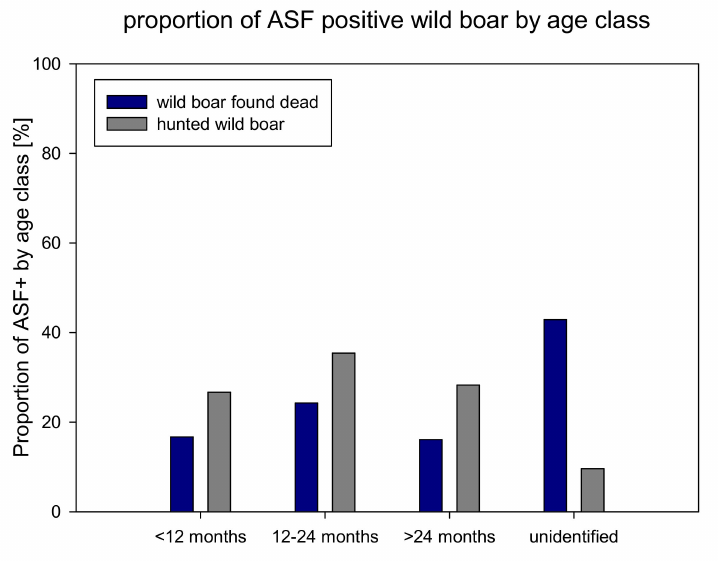
Figure 4. Proportion of ASF positive wild boar (hunted and found dead) by age class